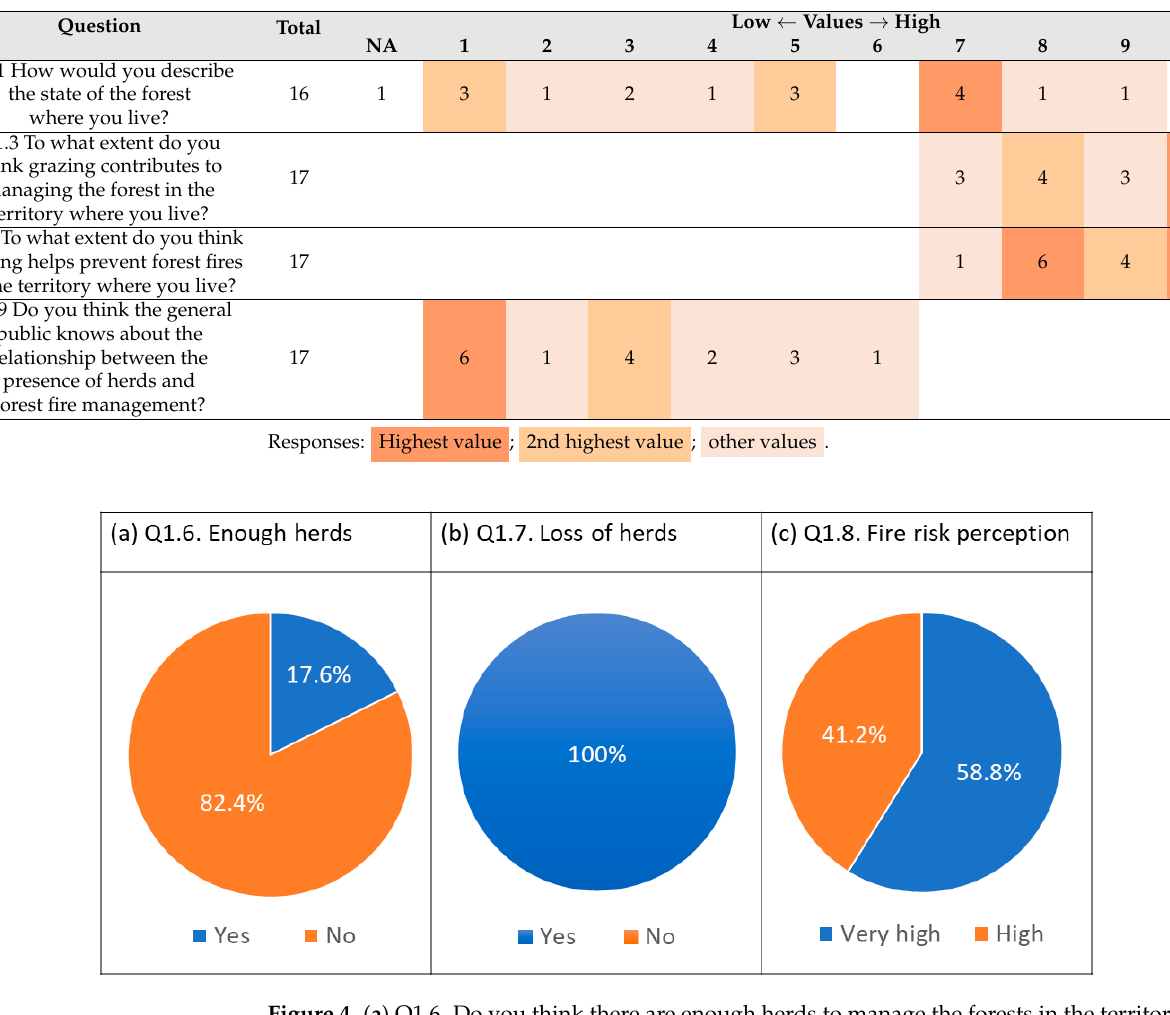
Table 2. Section 1 of the questionnaire—number of responses obtained for each value category. Val- ues for questions on a 1–10 scale (from low to